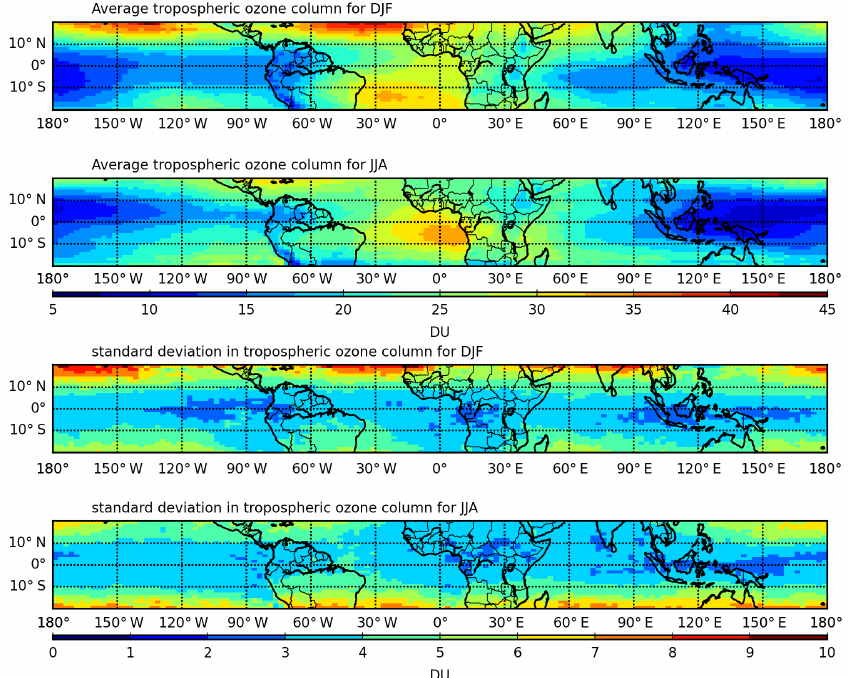
Figure 2. Top: mean tropospheric column ozone for December–February and June–August based on the merged CCD data set from all sensors for 1995 to 2015 (Sect. 3). Bottom: standard deviation of the tropospheric column ozone. Note the different colour bars for the TCO and its